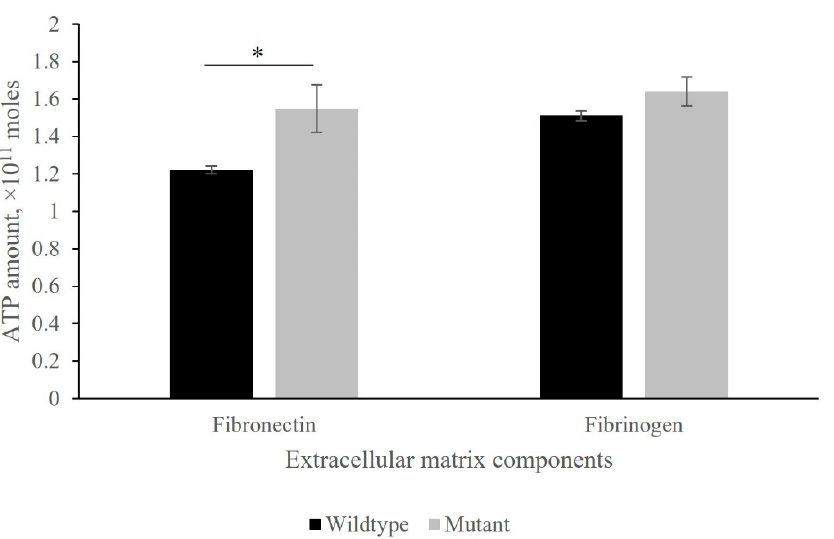
Figure 3. IsaA gene disruption affects fibronectin/fibrinogen binding. Adhesion of S. aureus ∆ isaA mutant and its parental strain SH1000 were examined for the immobilised extracellular matrix proteins fibronectin and fibrinogen. This was quantified as ATP amounts in a luminescence microplate reader. High levels of ATP were detected in the isaA mutant, with the range of 1.3 × 10 11 to 2.0 × 10 11